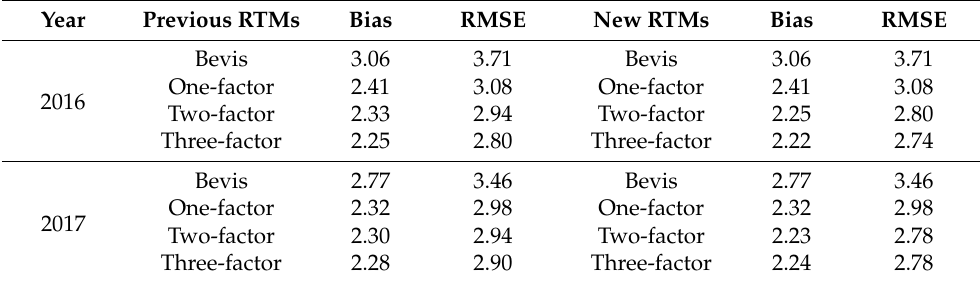
Table 6. Precision statistics of yearly multifactor RTMs (K).